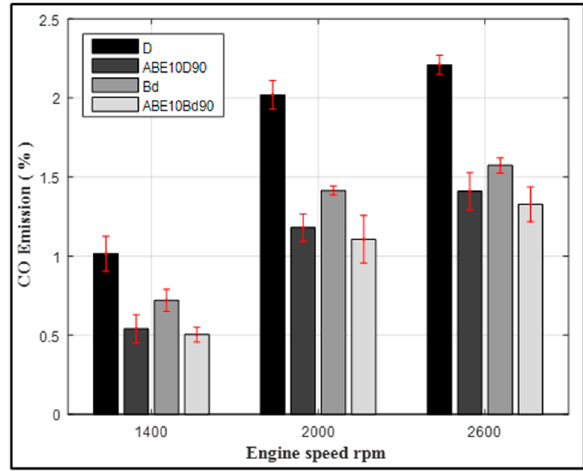
Figure 13. CO emissions of test fuels.